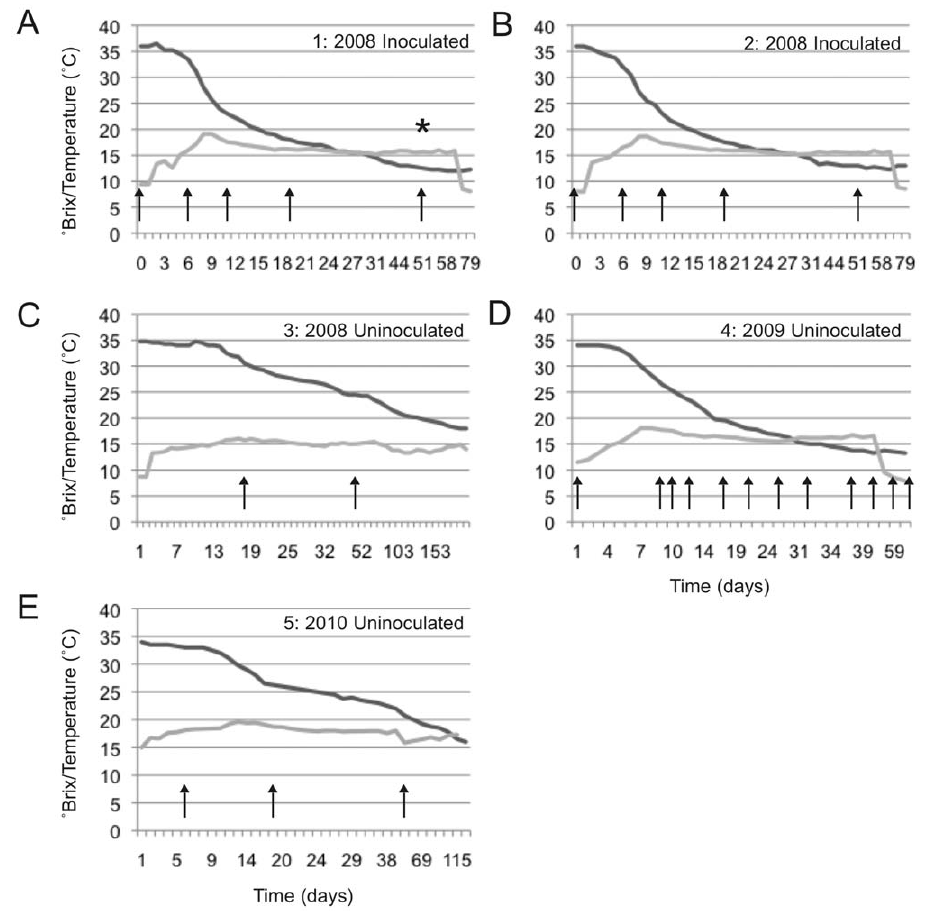
Figure 1. Fermentation rate and temperature of Dolce fermentations. Panel A: Batch 1, 2008 inoculated; Panel B: Batch 2, 2008 inoculated; Panel C: Batch 3, 2008 uninoculated; Panel D: Batch 4, 2009 uninoculated; Panel E: Batch 5, 2010 uninoculated. Dark grey= u Brix, Light grey=Temperature ( u C). Arrows represent sampling times. * Indicates sample used for culture-dependent analysis.